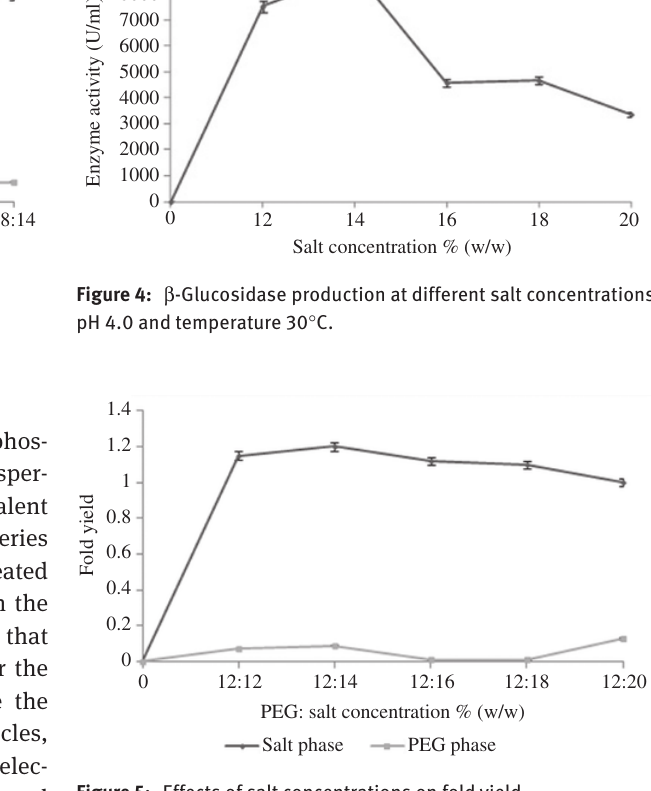
Figure 5: Effects of salt concentrations on fold yield. pH 4.0 and temperature 30 ° C.